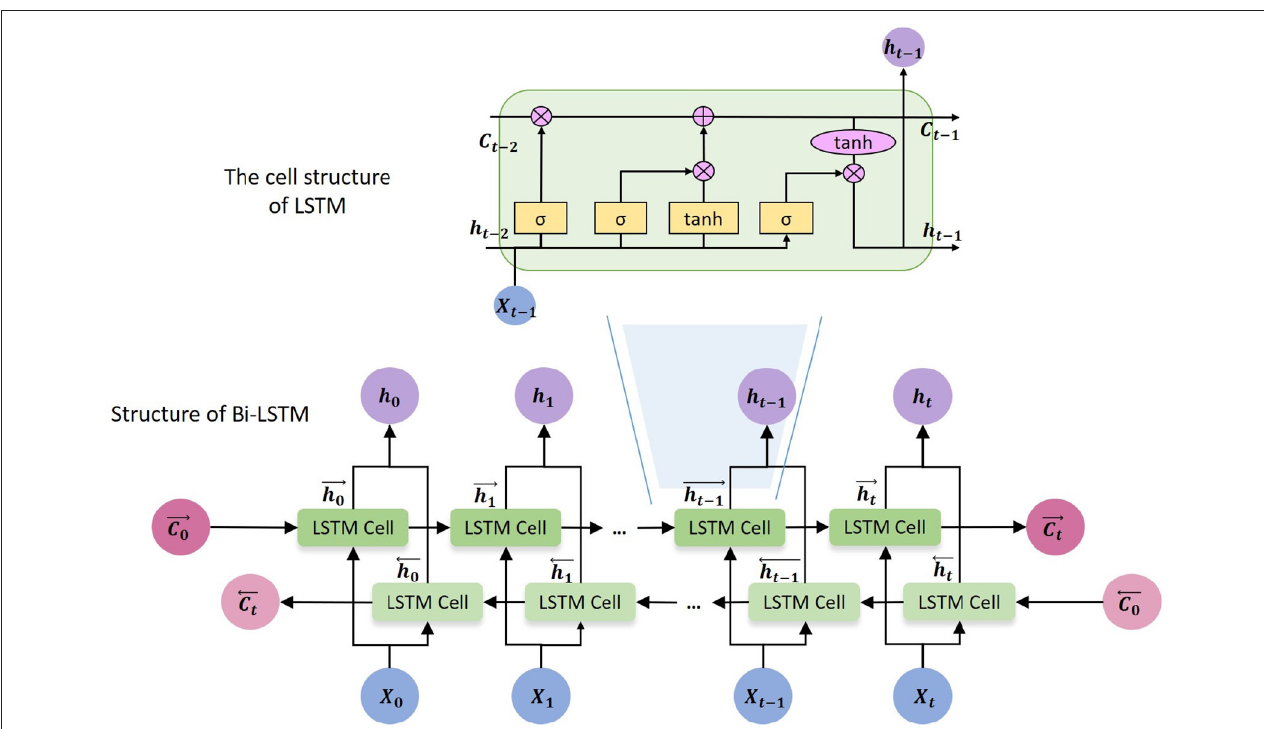
FIGURE 2 | The cell structure of LSTM and